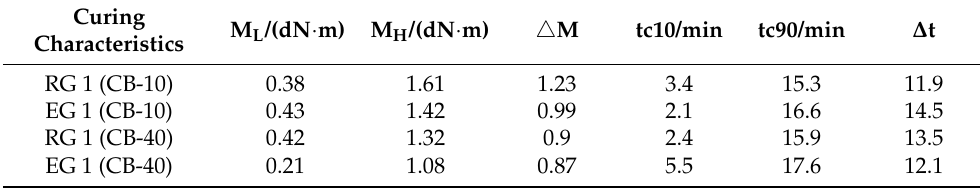
Table 2. Curing characteristic parameters.